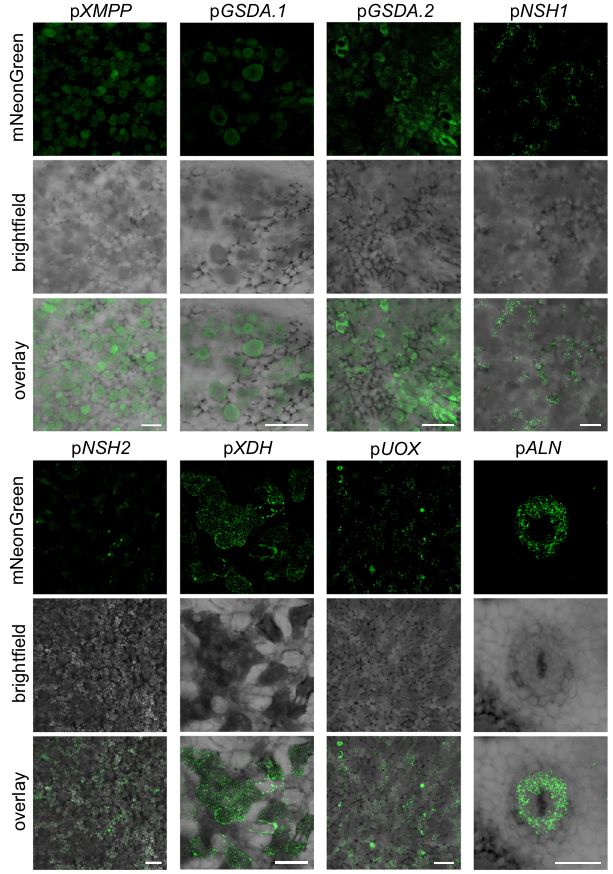
Fig. 5 | Cell-type speci fi c activity of ureide biosynthesis gene promoters in the common bean nodule. Confocal fl uorescence microscopy images of cross sec- tions from common bean nodulesexpressing the coding sequenceofperoxisome- targeted mNeonGreen under the control of native promoters of genes involved in ureide biosynthesis. The central infected region, consisting of infected (dark grey) and uninfected (light grey) cells, or the inner cortex with vascularbundle cells(for p ALN ) are shown. From top to bottom, mNeonGreen channel, bright fi eld channel and overlay of both channels. Scale bar, 100 µ m. Images are representative of at least three nodules from independent transgenic roots. The experiment was per- formed twice with similar